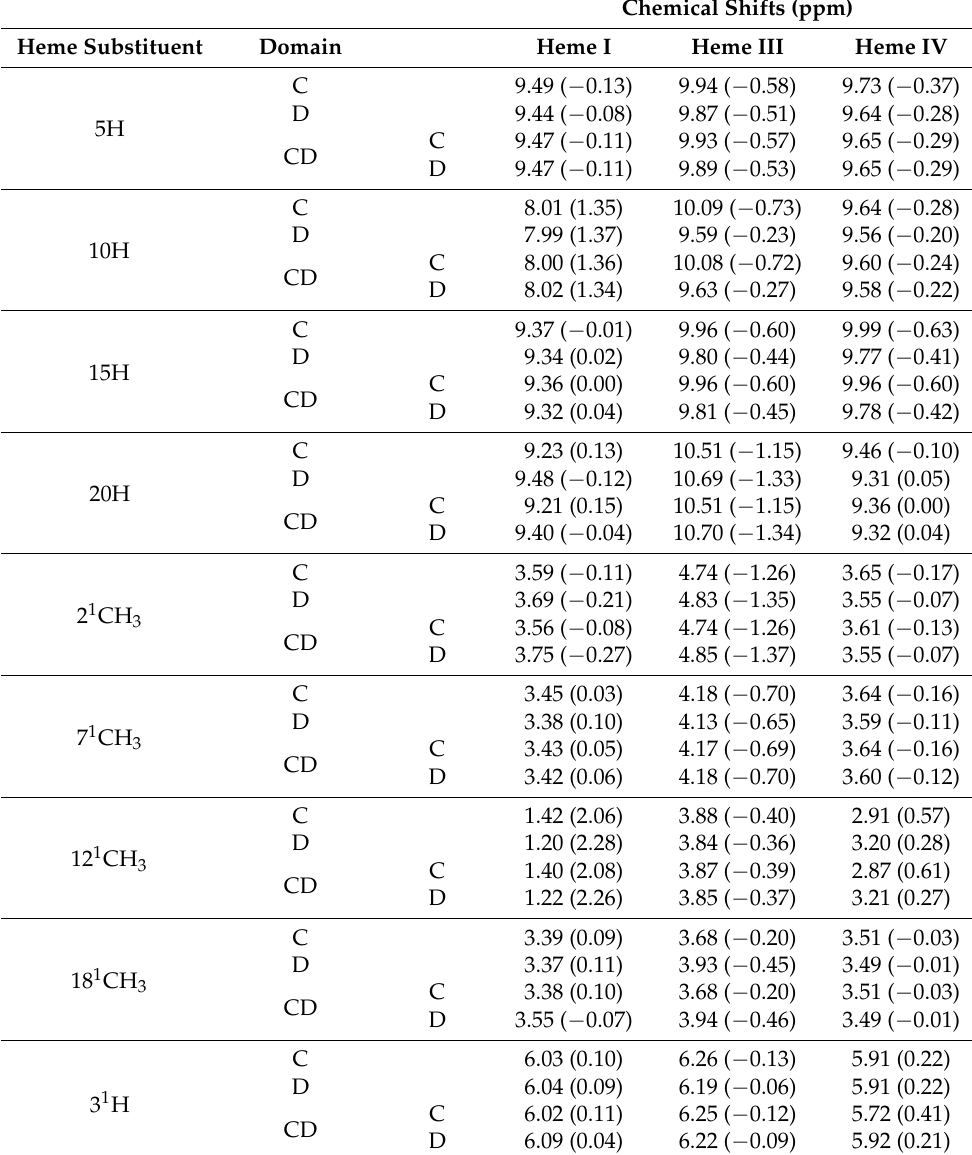
Table 1. Observed 1 H and ring current chemical shifts (in parentheses) of the heme protons of domains C, D and bi-domain CD in the reduced state at pH 8.0 and 288 K. Data for domain C were previously determined [22] and are indicated for